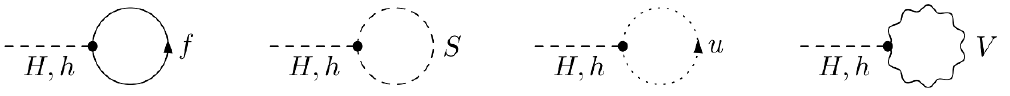
Figure 1 . Generic tadpole diagrams. There is one diagram for each massive fermion ( f ), scalar ( S ), gauge-boson ( V ), and ghost (cid:12)eld ( u ). At NLO the renormalized tadpole ^ T consists of a counterterm contribution (cid:14)t and